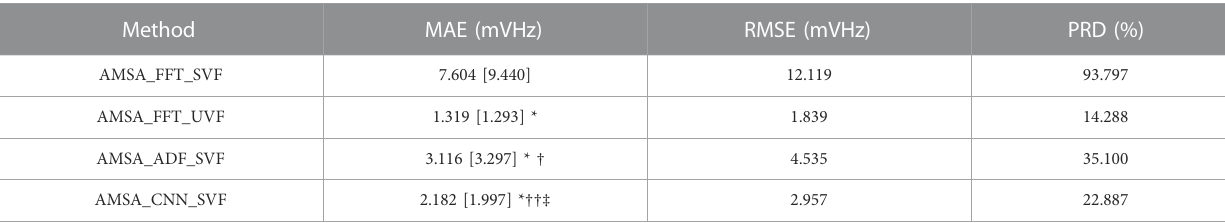
TABLE 2 Performance of different AMSA estimation method using simulation data.